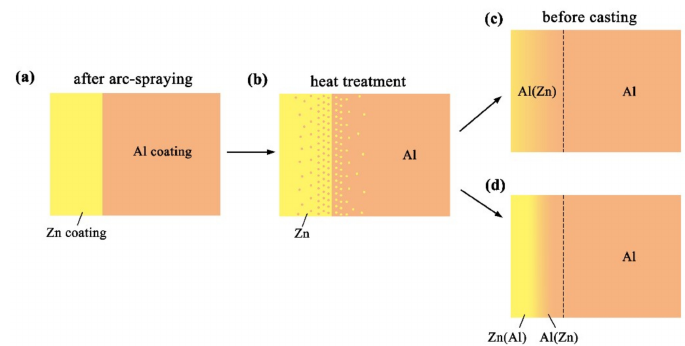
Figure 11. Schematic illustrations of the Al / Zn double-deck coating preheat